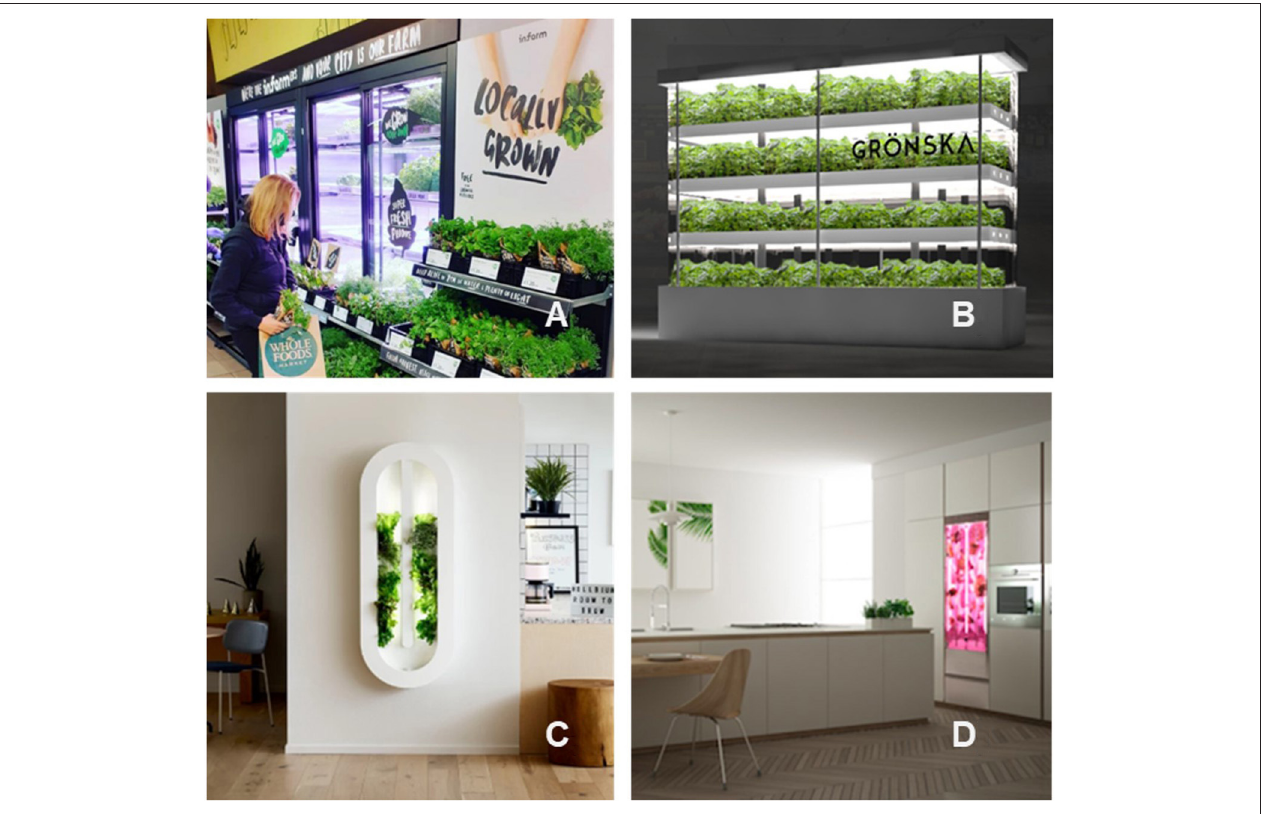
FIGURE 2 | Depiction of different types of GSS systems analyzed in the study, with (A) showing an in-store farm by InFarm (2021), (B) showing an in-store/in-restaurant farm by Grönska (2021), (C) depicting a growing unit in an office environment by Hollbium (2021), and (D) showing a B2C example by Natufia (2021)